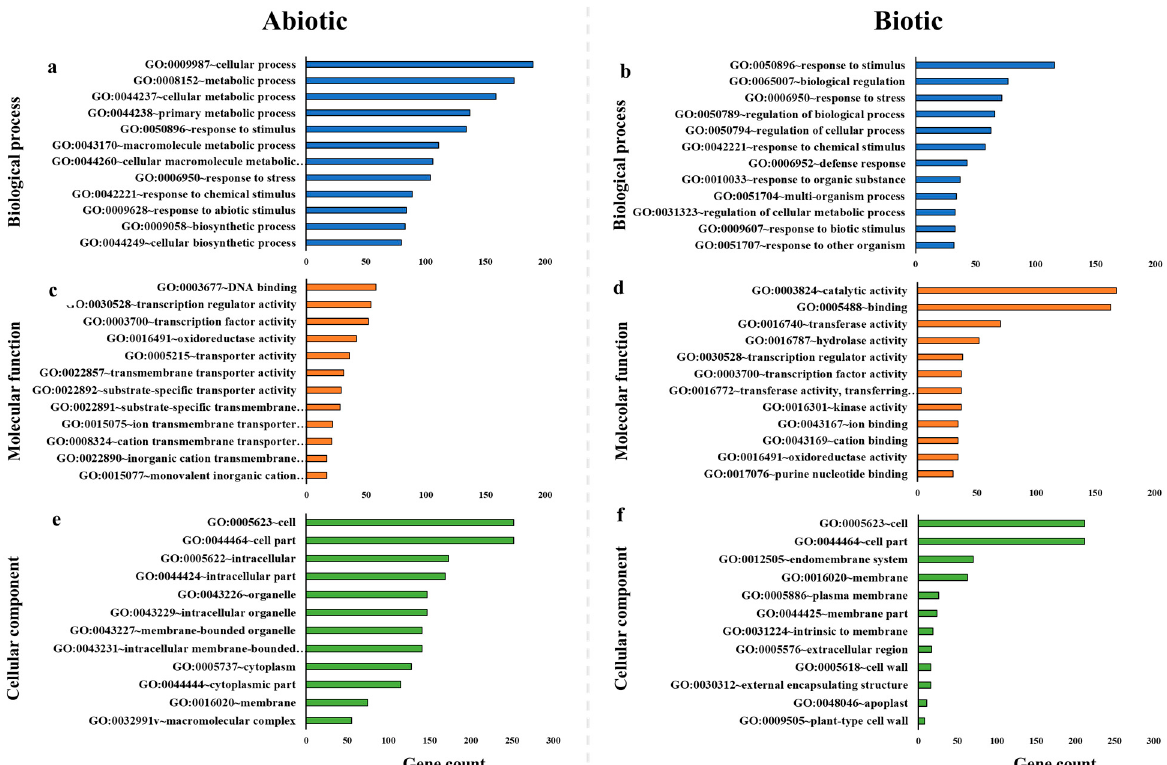
Figure 2. Gene ontology enrichment analysis of the DEGs under abiotic ( a , c , e ) and biotic ( b , d , f ) stresses. The enriched genes were sorted into three categories according to gene function and biological process, i.e., genes involved in molecular functions and genes responsible for synthesis and organization of cellular components.